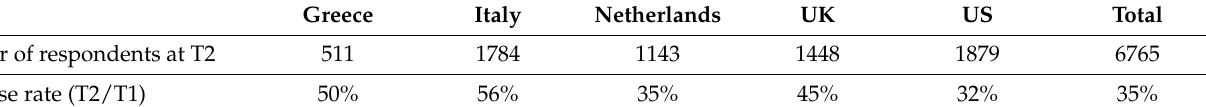
Table 1. Characteristics of respondents at T1 (April–May